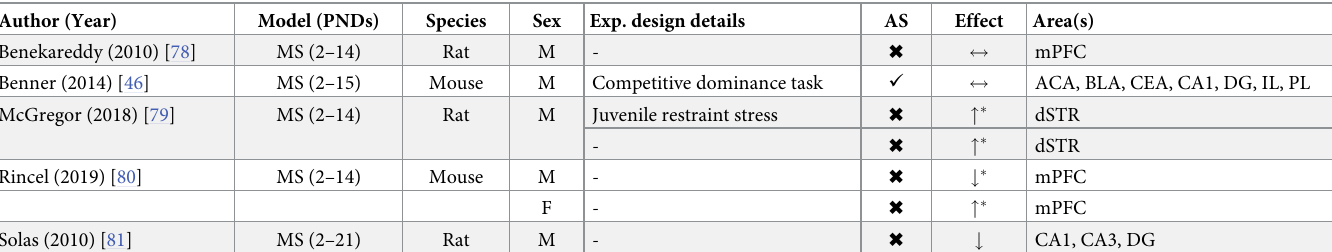
Table 2. Overview of study designs and findings of reviewed publications reporting on Arc expression in ELA and control animals.